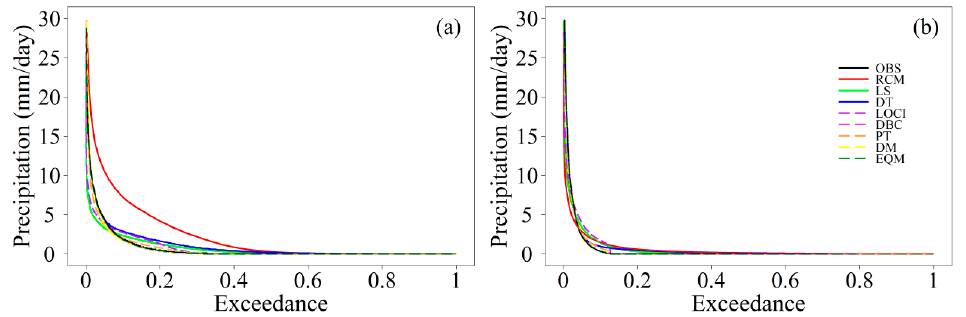
Figure 4. Exceedance probabilities of the observed, RCM, and bias-corrected precipitation in BYBLK ( a ) and BLT ( b ) meteorological stations.